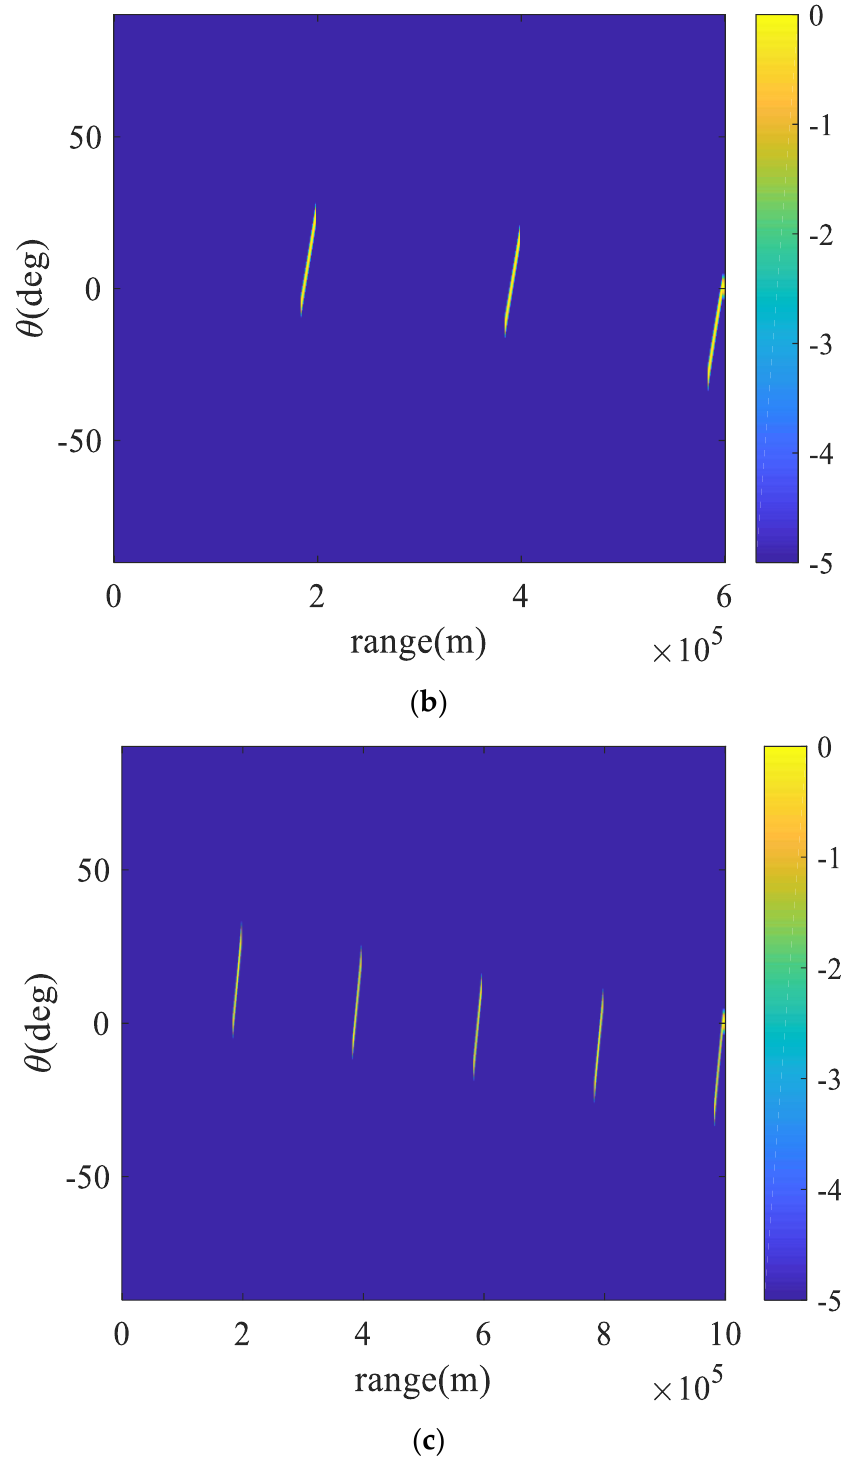
Figure 9. Simulation diagram of FDA main lobe moving between pulses. ( a ) Conventional non-full angle FDA; ( b ) after MLC non-full angle FDA; ( c ) coherent pulse number K = 5 MLC FDA.